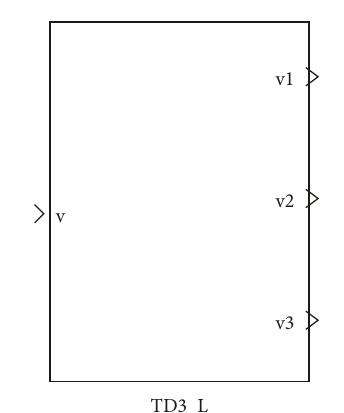
Figure 13: The TD3_L subsystem module after packaging.